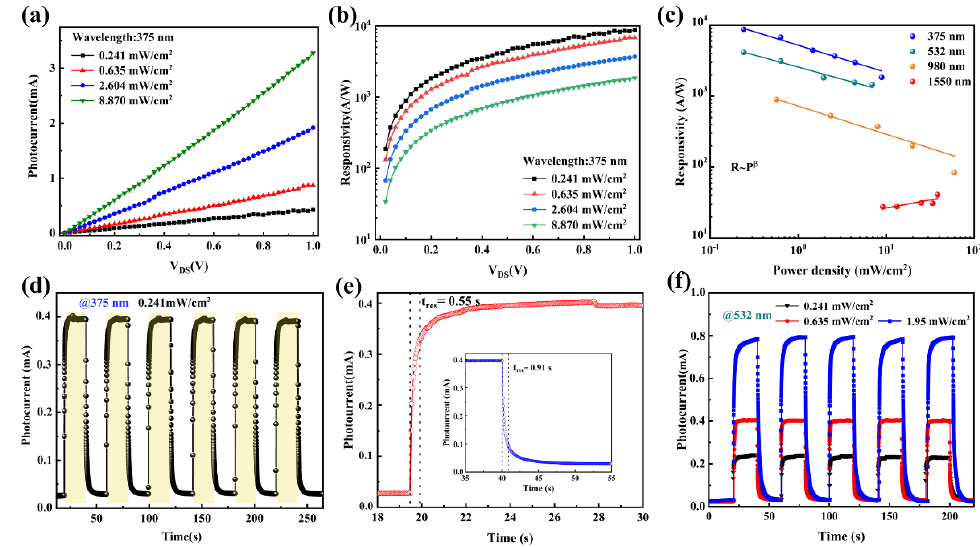
Figure 3. ( a ) Photocurrent and ( b ) responsivities vs. source-drain voltage curves at different light power densities; Wavelength: 375 nm; V G = 0 V. ( c ) Relationships of responsivity and light power density at different light wavelength. Balls are the experimental data of responsivity, which are abstracted from the output characteristics; V G = 0 V, V DS = 0.1 V. ( d ) Time-dependent photocurrent of the photodetector at incident light wavelengths of 375 nm; excitation power: 0.241 mW/cm 2 , V G = 0 V, V DS = 0.1 V. ( e ) Single-cycle time-dependent photocurrent for rising/falling time analysis in figure d. ( f ) Time-dependent photocurrent of the photodetector at incident light wavelengths of 532 nm.